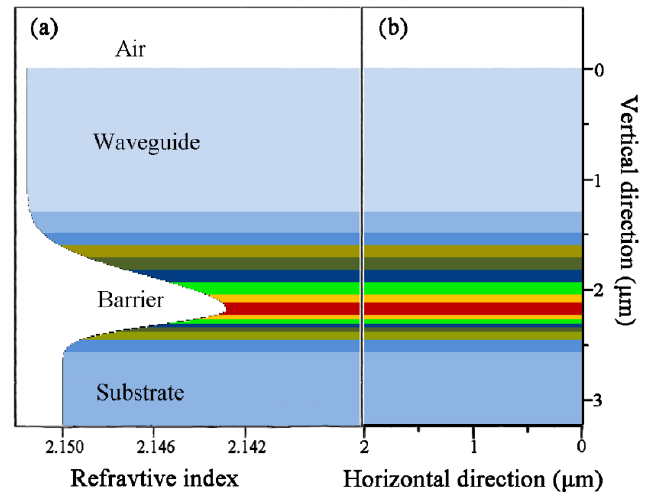
Figure 2. ( a ) 1D and ( b ) 2D refractive index profiles near the crystal surface after oxygen ion irradiation.